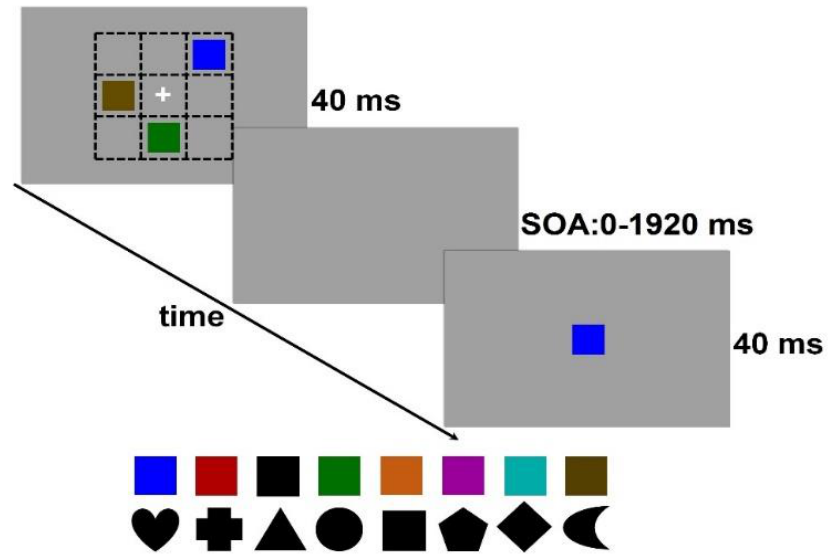
Figure 2. Example of color stimuli used in the VSTM scanning task. A 40–ms study display, here with a VSTM load of 3, was followed, at SOAs varying from 0 to 1920 ms, by a 40–ms probe centered at fixation. The observer was to respond as quickly and accurately as possible whether the probe (as shown) matched one or mismatched all of the items in the study display. Dashed line matrix designates the notional 3 × 3 matrix in which the central probe and the surrounding color or shape stimuli were positioned.